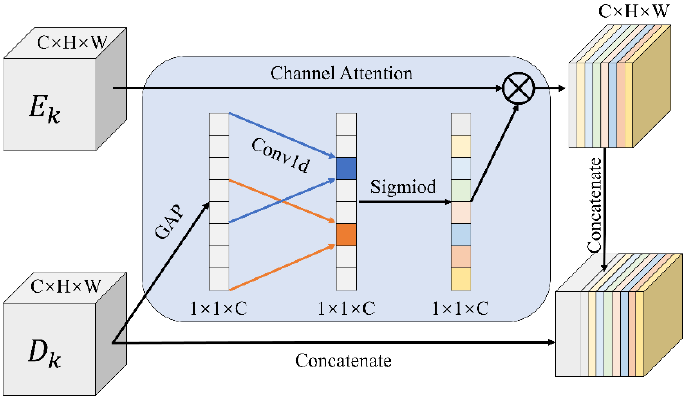
Figure 4. The structure of the CLFR module.